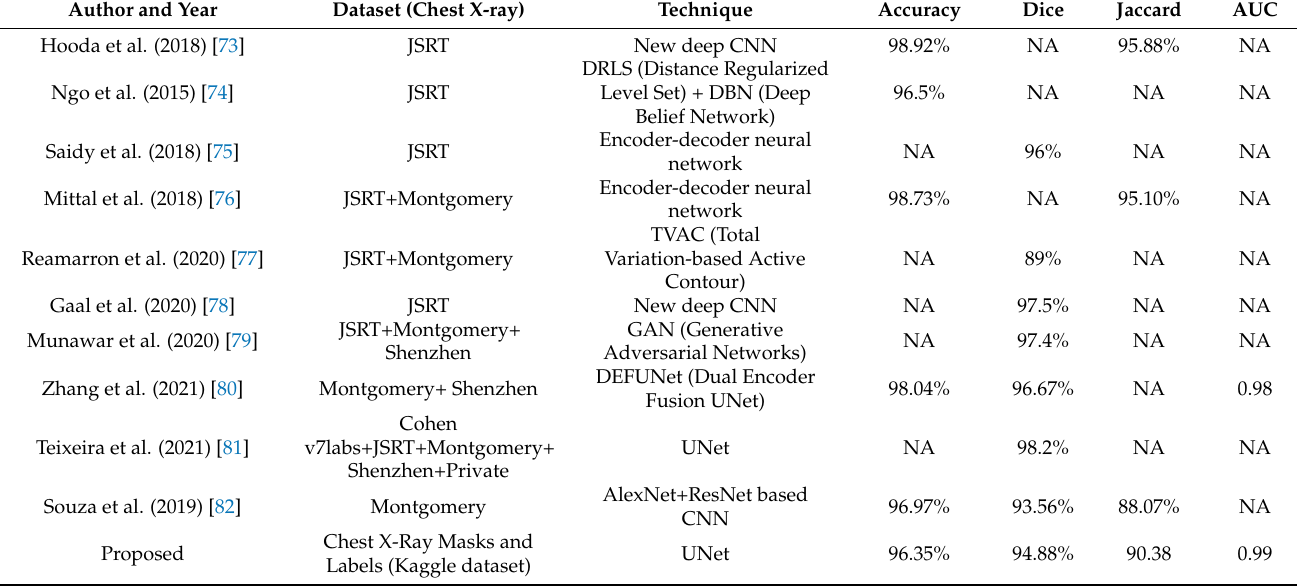
Table 4. Benchmarking table-showing comparison of proposed and existing segmentation